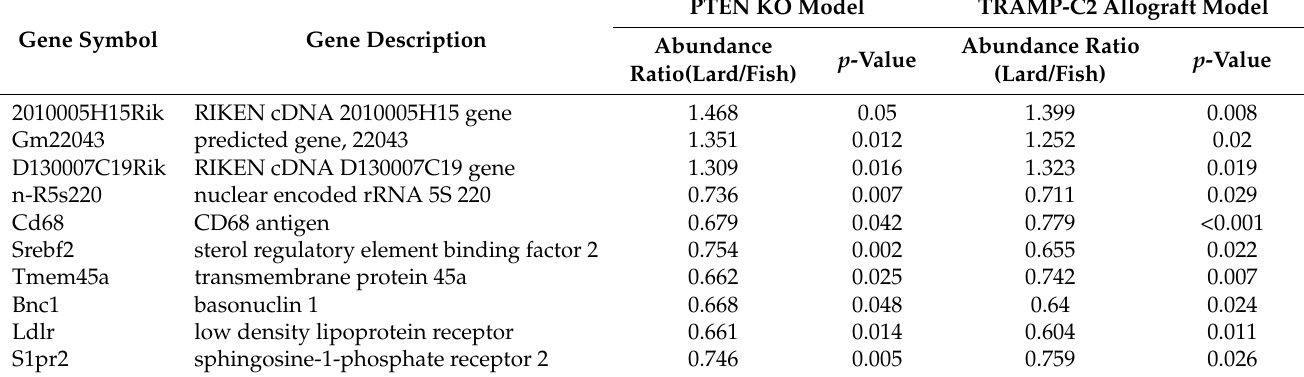
Table 1. Commonly regulated genes in two mouse models of prostate cancer fed with a lard diet and fish oil diet.